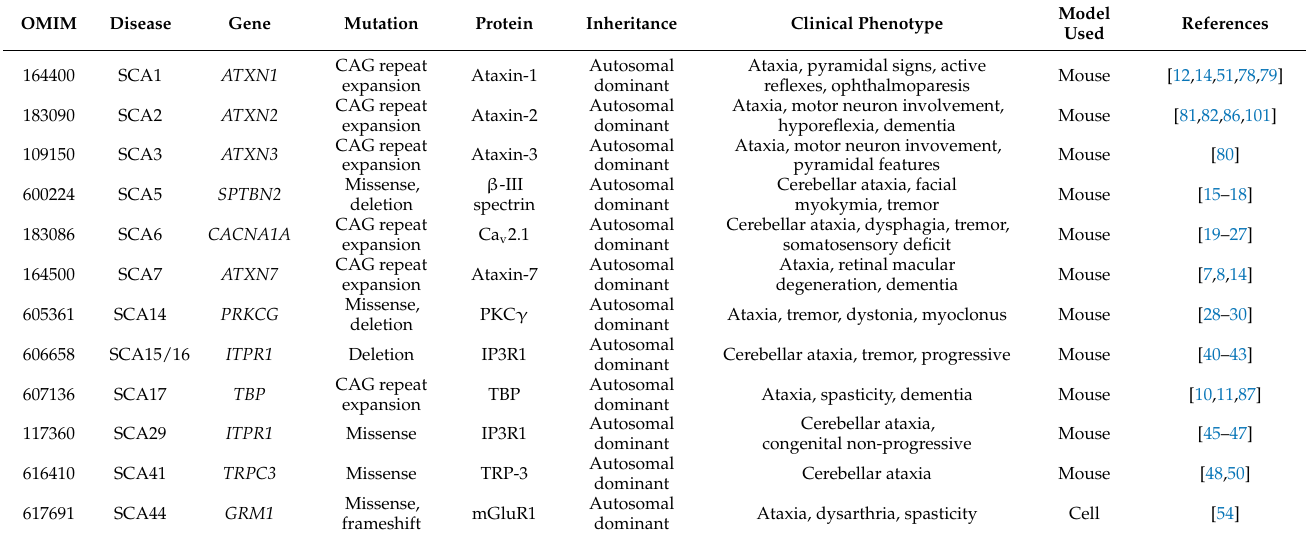
Table 1. The main SCA subtypes associated with mGluR1-PKC γ signaling